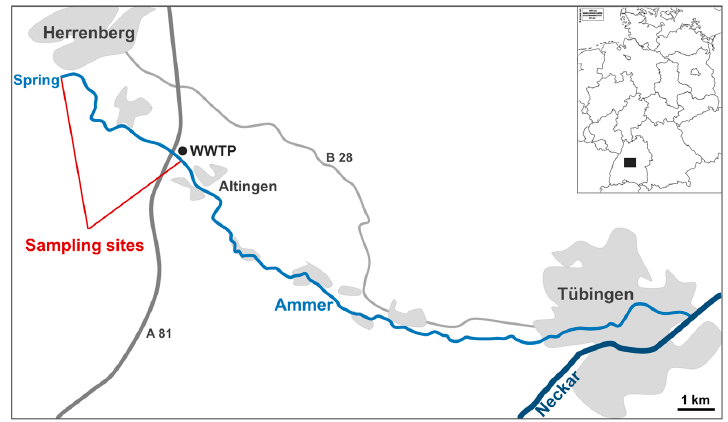
Figure 1. Map of the sampling sites at the River Ammer in southwestern Germany. Urban areas are marked in grey. The location of the wastewater treatment plant (WWTP) for the city of Herrenberg is indicated. Sampling sites are marked in red. For orientation highway A 81 and federal road B 28 are indicated).